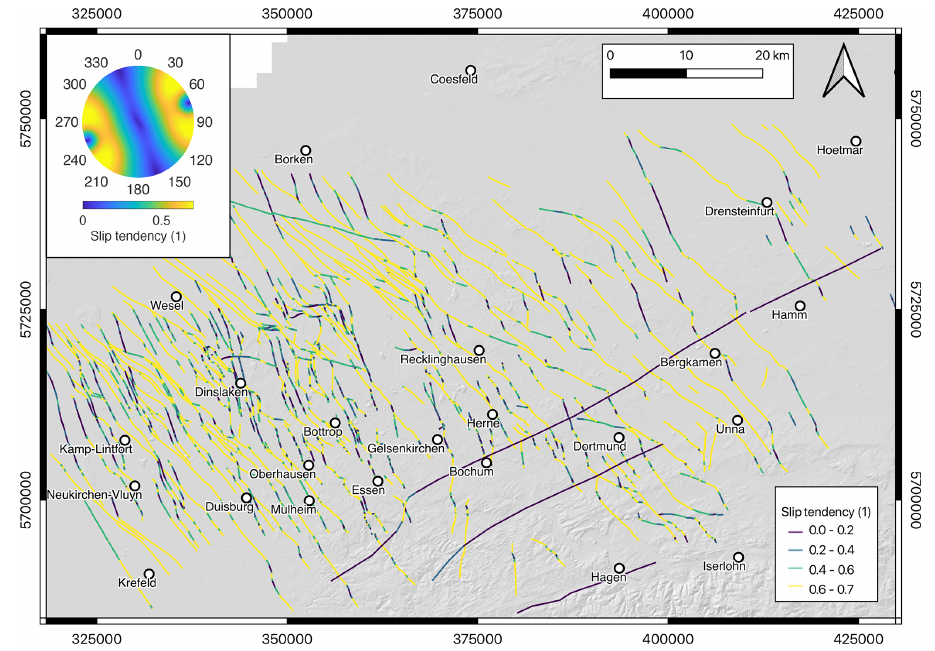
Figure 9. Slip tendency of geological discontinuities within the Ruhr region (GD NRW, 2017, 2019) at depth of 1200m computed based on the stress tensor constrained from this study with P p of 11.8MPa, S hmin of 17.4MPa, S Hmax of 33.7MPa, S v of 29.3MPa, and average S Hmax orientation of 161 ◦ . Stereographic projection of slip tendency based on the constructed stress tensor is presented in the top left corner.